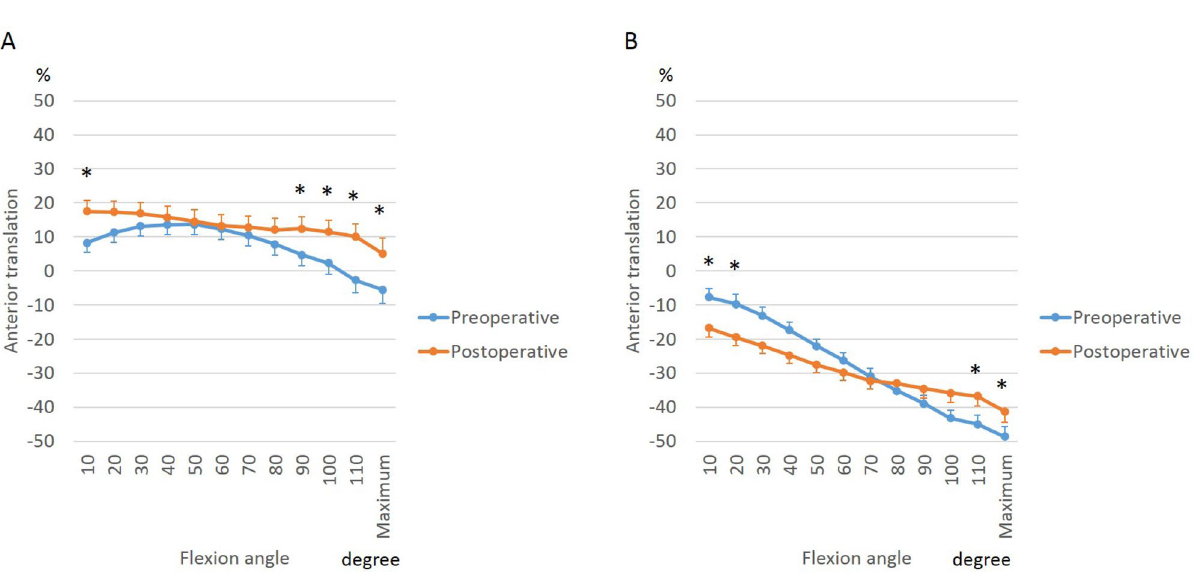
Figure 2. Differences in knee kinematics between squatting and cross-legged sitting: external rotation ( A ) and valgus ( B ) of femoral component relative to tibial component.